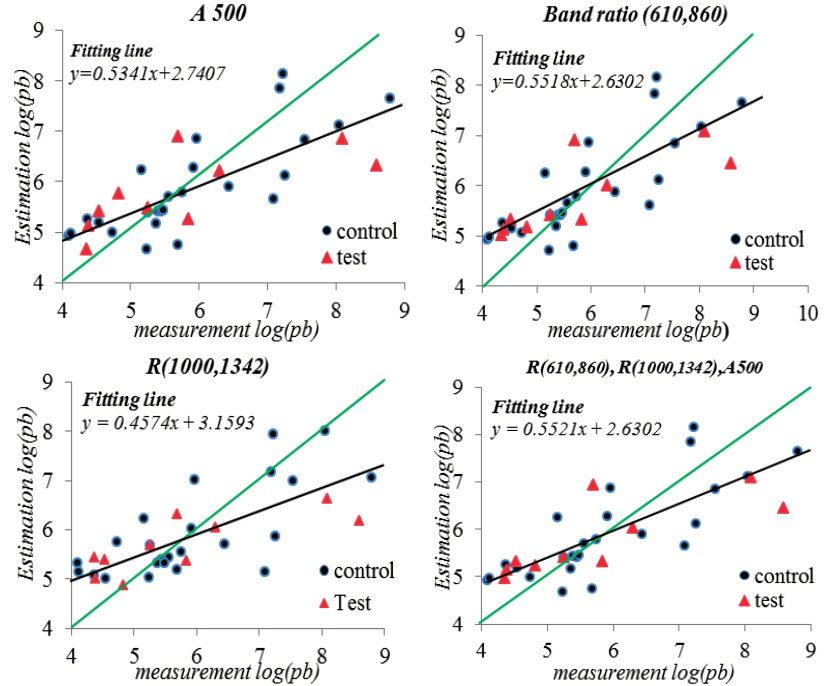
Figure 6. The scatterplot of estimations and expected the Pb concentration in simple linear regression